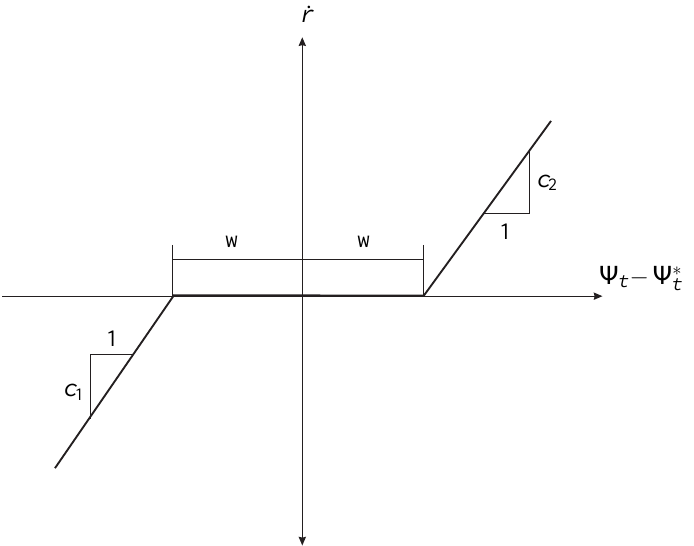
Figure 4. The Mechanostat Theory as interpreted by Beaupré et al. [3]. This law establishes a stepwise linear relationship between the bone formation/resorption rate, ˙ r , and the difference between the mechanical stimulus, Ψ t , and a reference value of that stimulus, Ψ ∗ t